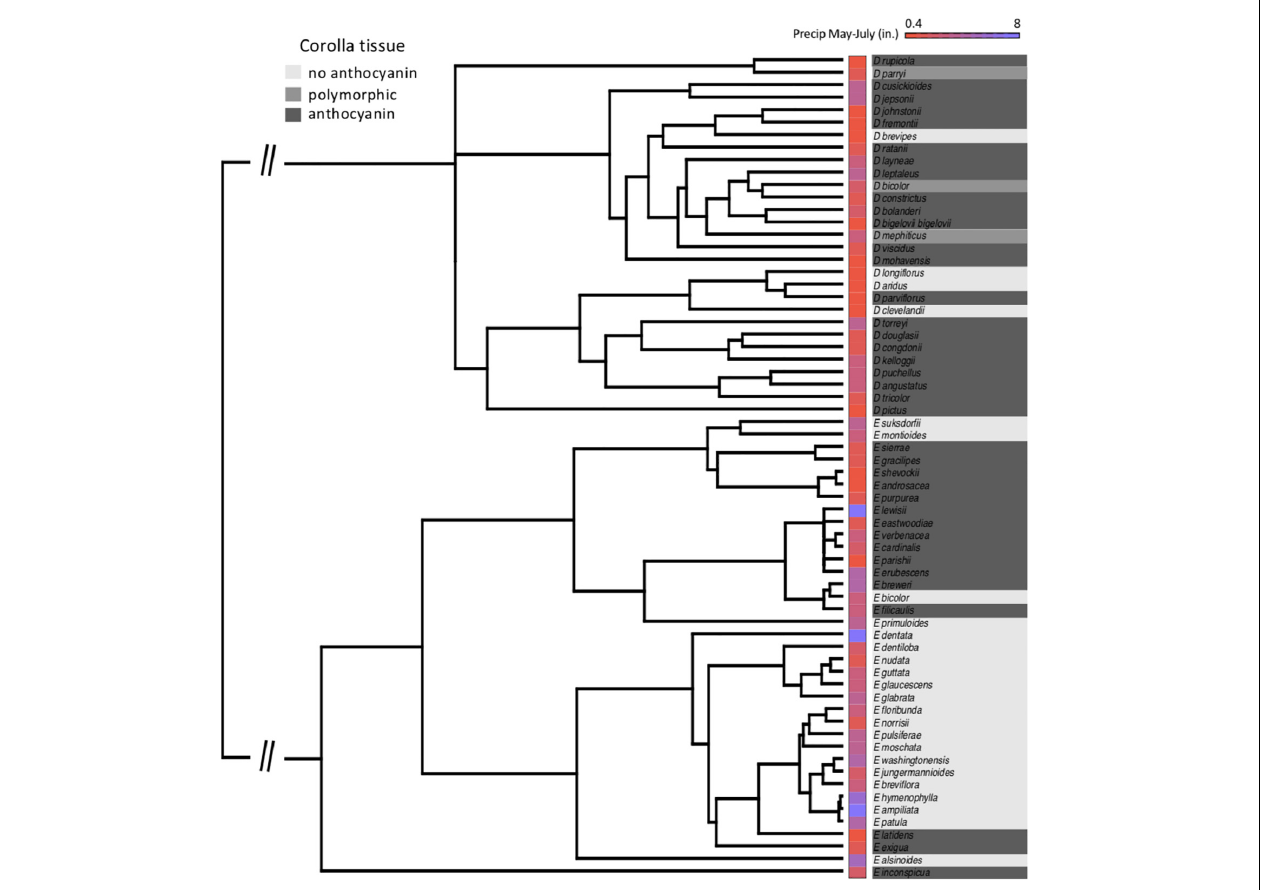
FIGURE 4 | Species’ relationships in clades Diplacus and Erythranthe , with floral anthocyanin and average precipitation during peak flowering (May–July) indicated. Note that the phylogeny is pruned to only include species in the present study ( N = 66).